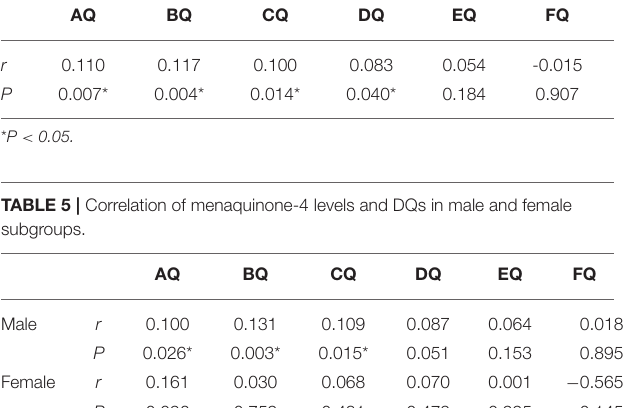
TABLE 4 | Correlation of menaquinone-4 levels and DQs in children with ASD. AQ BQ CQ DQ EQ FQ